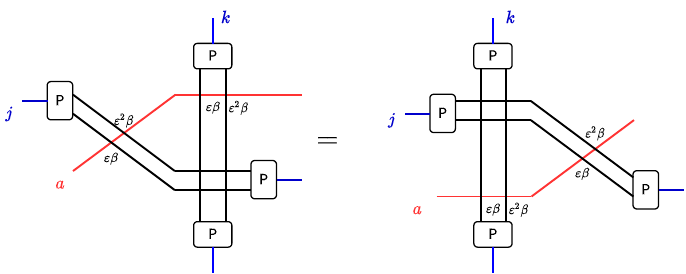
Figure 3: A pictorial proof of (73). We omit the M matrix parts in the Lax opera- tor (70), which do not change the